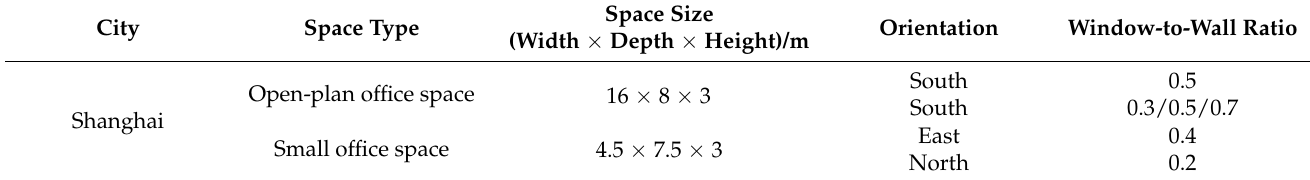
Table 4. Model related